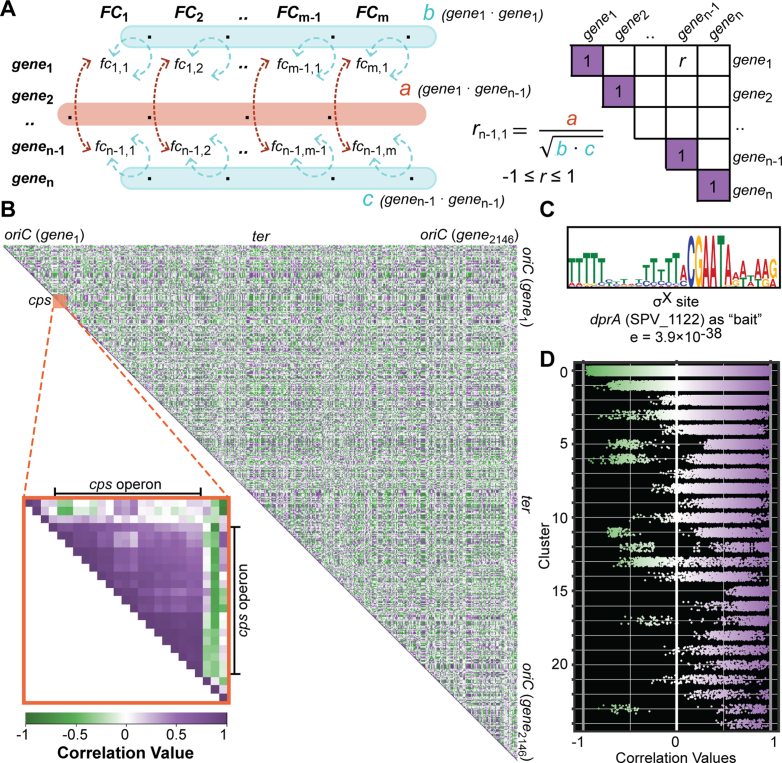
Assembly of the co-expression matrix from the correlation values of every two pneumococcal genes. (A) The exhaustive fold changes calculated for every set of two genes are converted into a correlation value: first, the dot-product between two genes (a, orange) and the dot product of each gene with itself (b and c, blue) are calculated. The correlation value is the ratio between a and the geometric mean of b and c. Values were assembled by the genomic coordinates of the target genes. (B) The co-expression matrix as a visualized gene network. Self-correlation values are 1 by definition and correlation values were plotted according to the genomic positions of target genes. Purple and green indicate positive and negative correlation values between two genes, respectively. Color intensities represent correlation strength. Blocks of highly correlated genes close to the matrix diagonal indicate operon structures, for example for the cps operon (inset). (C) An enriched promoter motif recovered from genes highly correlated with dprA (SPV_1122) matches the consensus ComX-binding site (78). (D) Pneumococcal genes were clustered into 25 clusters based on TPM. Then, correlation values for every two genes within each cluster were plotted. Cluster 0 is non-modular, and its correlation values can be considered as random. Within-cluster values showed a clear trend toward higher correlation (purple).